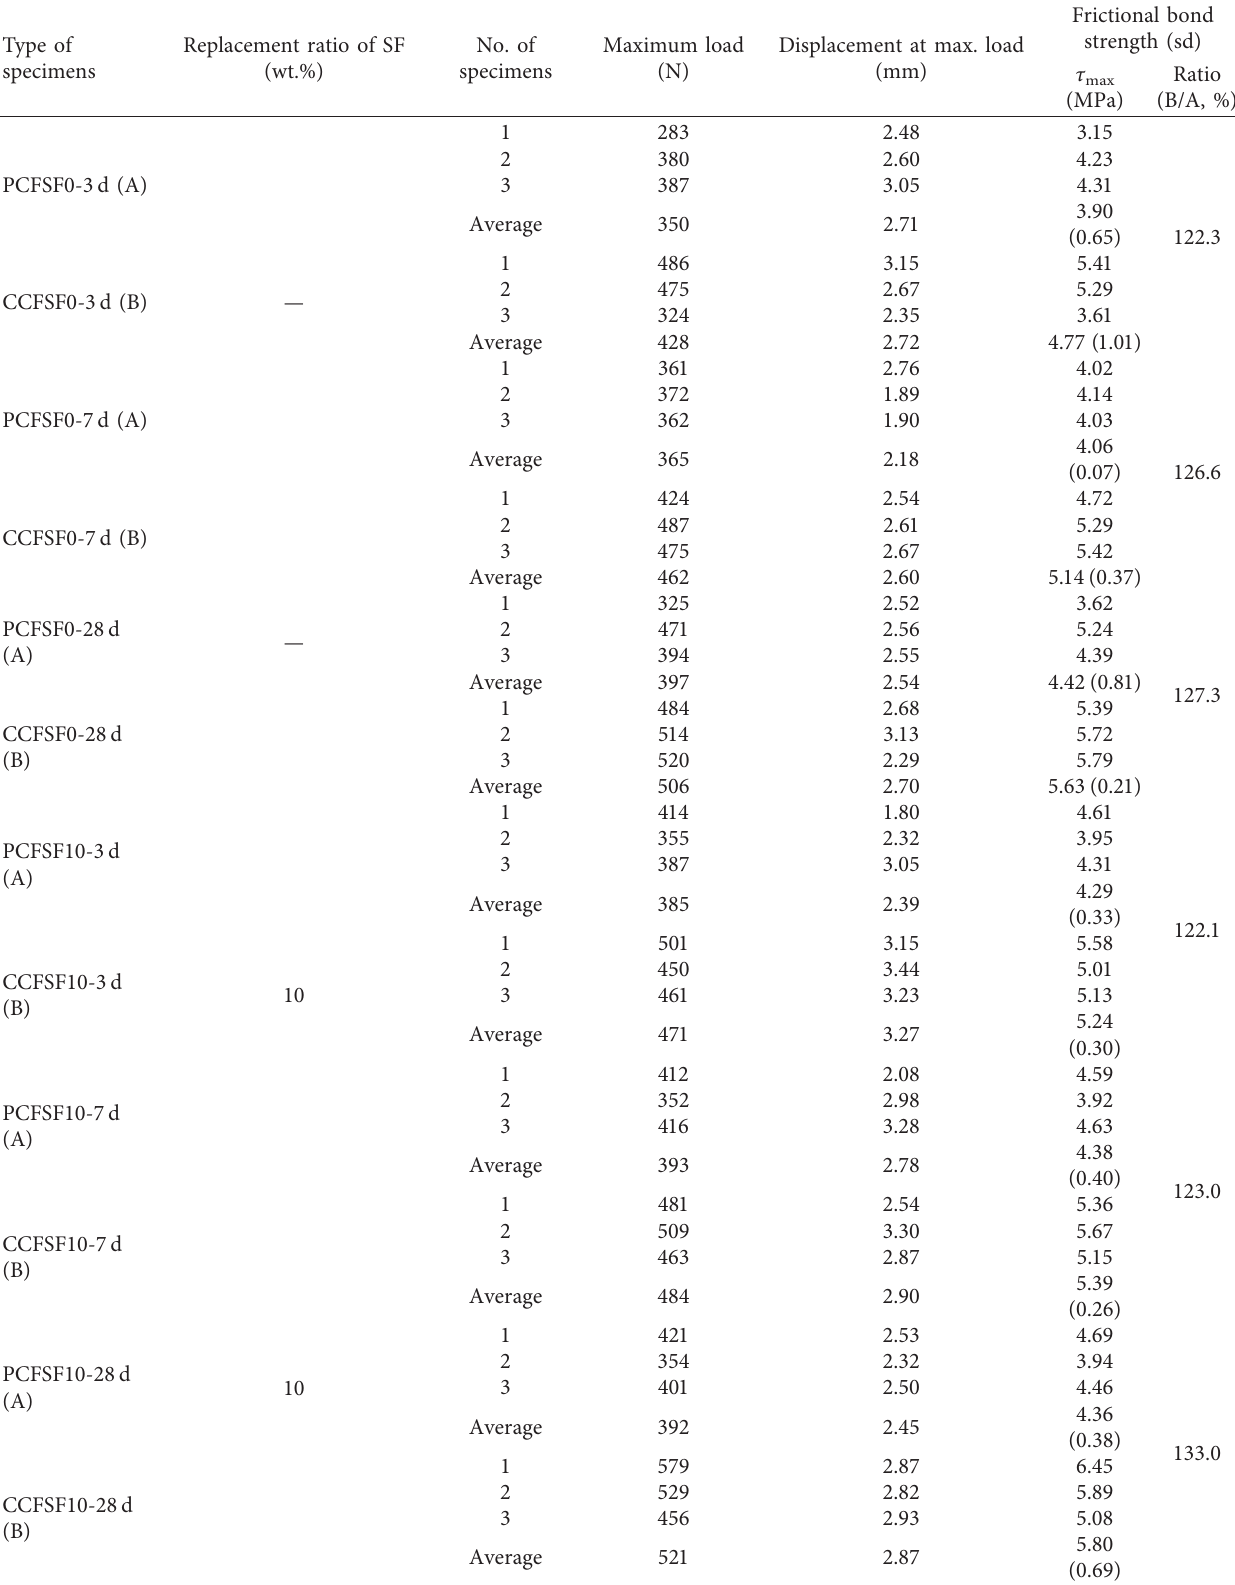
Table 5: Obtained results from the pull-out